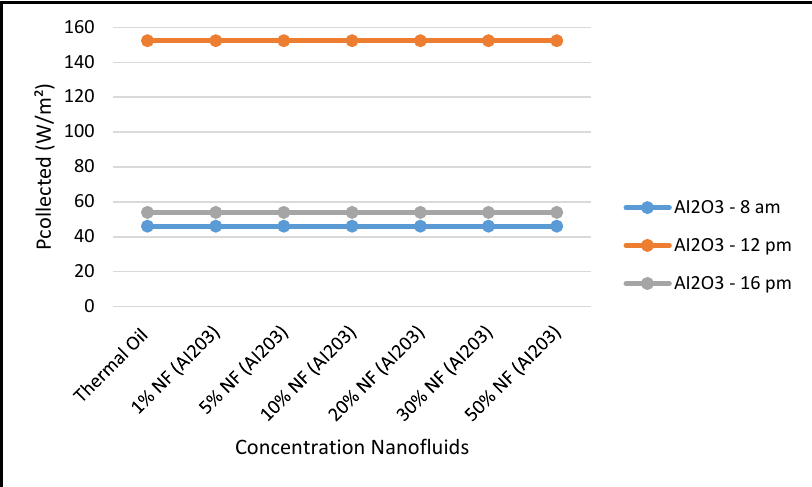
ff erent concentrations of Al 2 O 3.